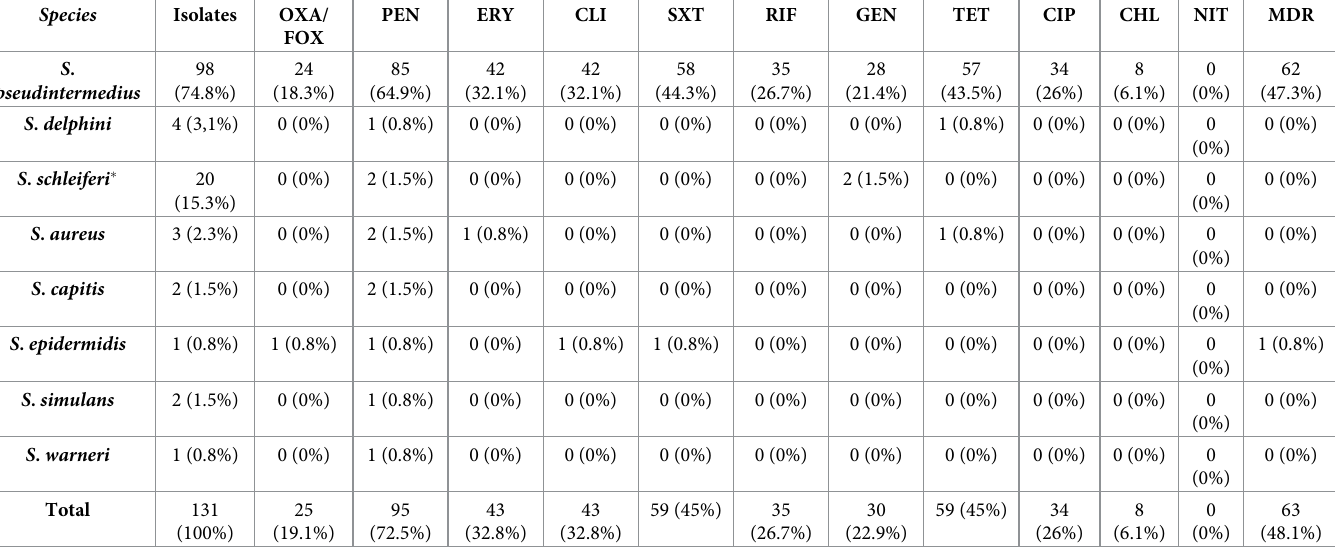
Table 2. Antimicrobial resistance among staphylococci isolates from infected dogs attended at two different veterinary clinics, from 2017 to 2020, in Belo Hori- zonte,